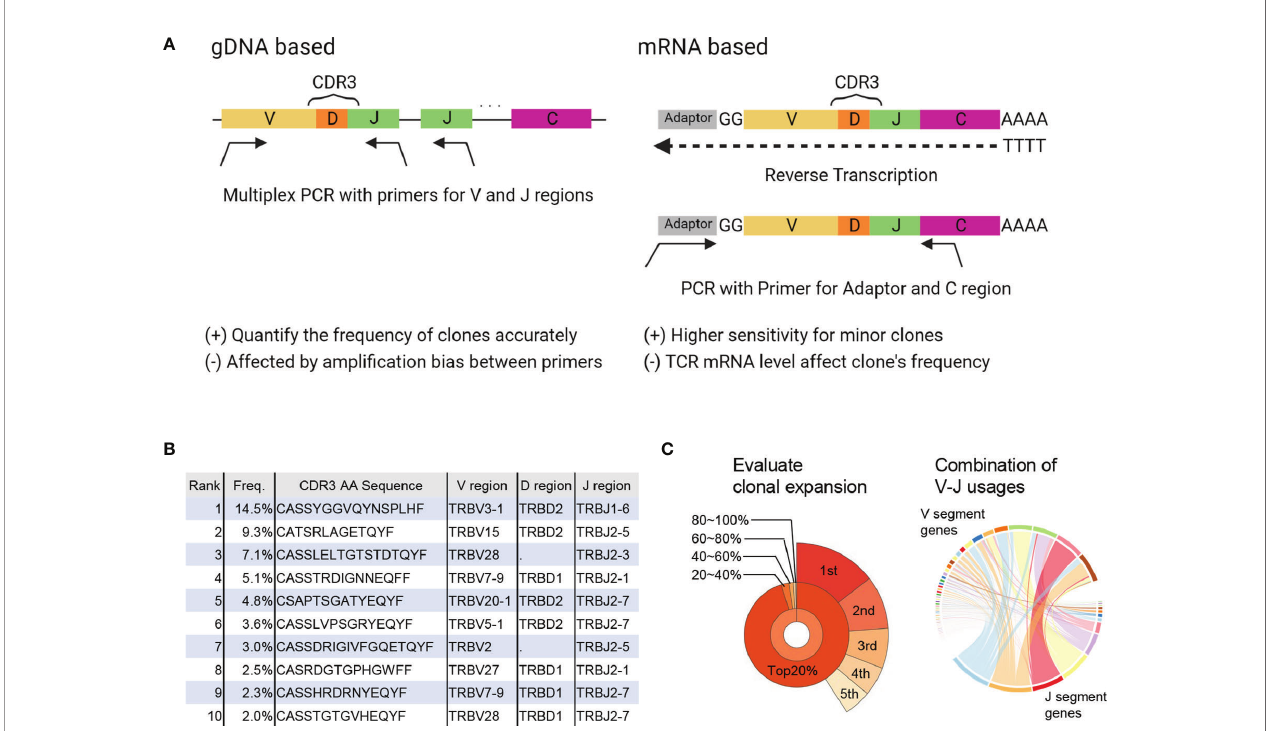
FIGURE 1 | Summary of TCRseq and TCR repertoire analysis. (A) Exemplary work fl ow of TCR library preparation methods. Genomic (g) DNA-based methods use a primer set designed to cover all V or J regions. Multiplex PCR is used to amplify CDR3 generated by V(D)J recombination. In the messenger (m)RNA-based method, an adaptor sequence is attached to the 5 ′ end of mRNA in the reverse transcription reaction. Then, TCR cDNA containing CDR3 is ampli fi ed using primers targeting the C region and adaptor sequence. (B) Output of primary analysis: table of T-cell clones with their frequency, CDR3 sequence, and usage of V, D, and J gene segments. (C) Output of secondary analysis. (left) Pie chart of the frequencies of top1 – 5 clones (outer layer) and total frequencies of top20%, 20 – 40%, 40 – 60%, 60 – 80%, and <80% of clones (inner layer). (right) Circos plot representing the proportion of each combination of V-J segment usage. The widths of the ribbons connecting V (upper side) and J (lower side) segments correspond to the total frequency of clones with the given combination of V-J segment